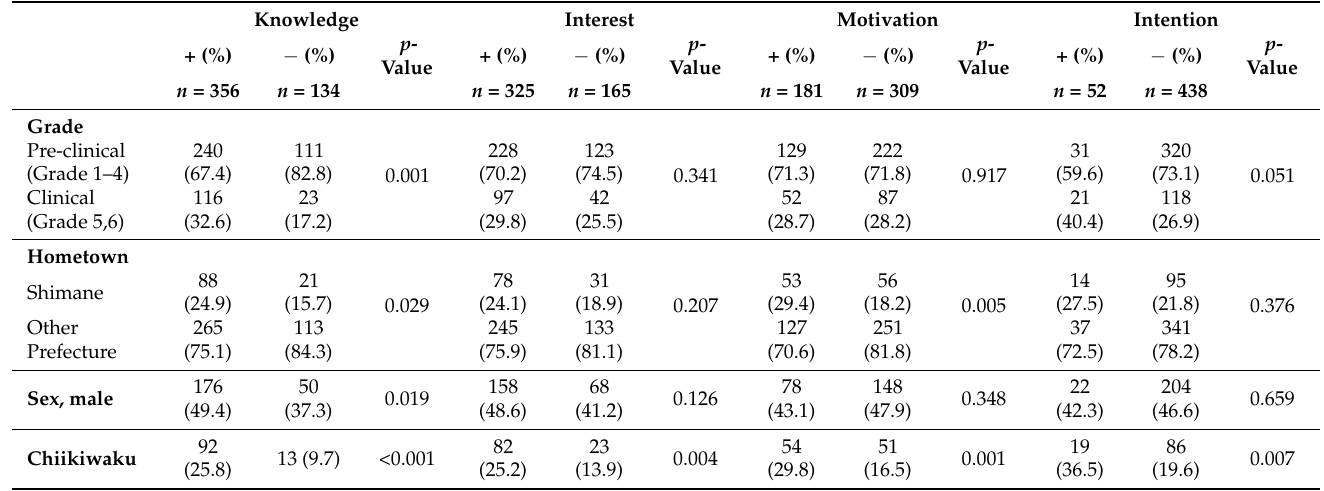
Table 2. Characteristics of the participants and their perceptions regarding general medicine, classified by their